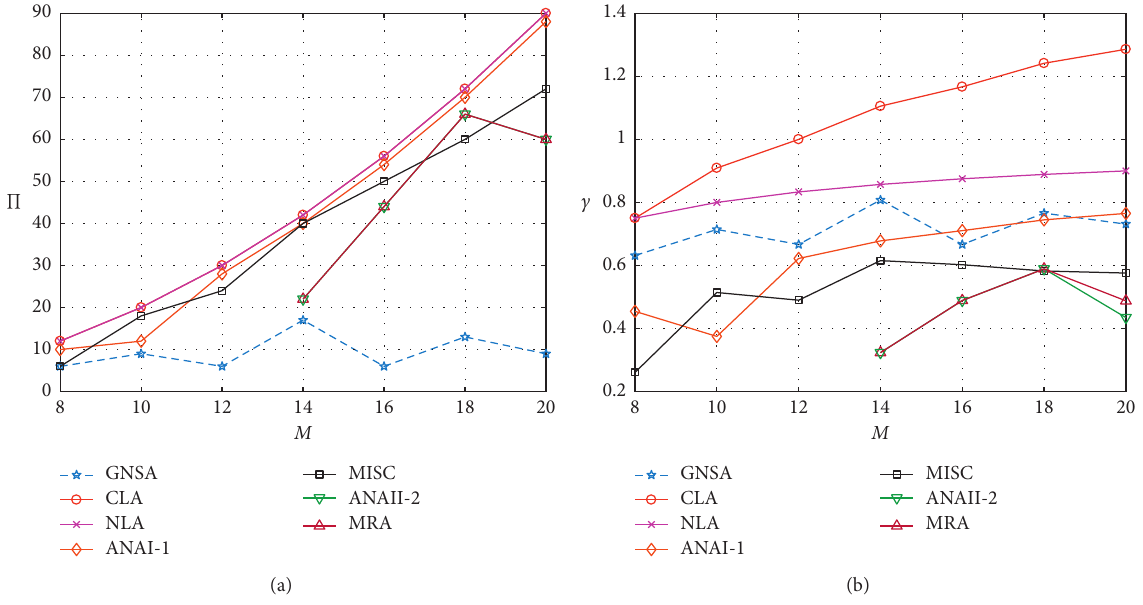
Figure 3: The comparison of Π and c in different sparse